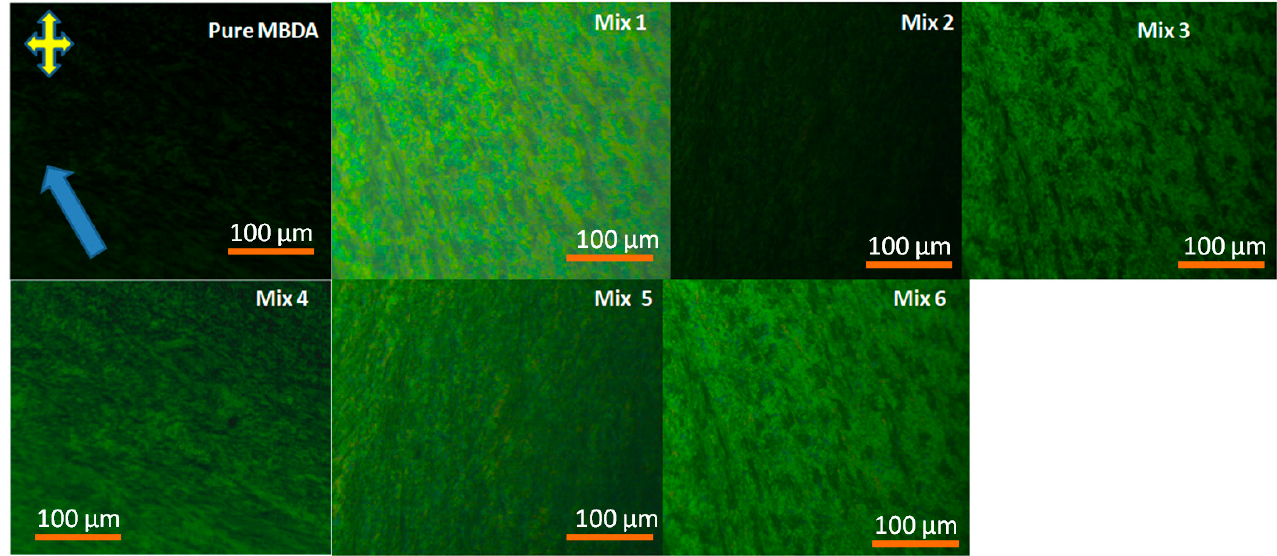
Figure 2. Polarizing optical micrographs for pure nematic MBDA and its mixture with core/shell quantum dots (Mix 1 to Mix 6) at a temperature of 56 °C.